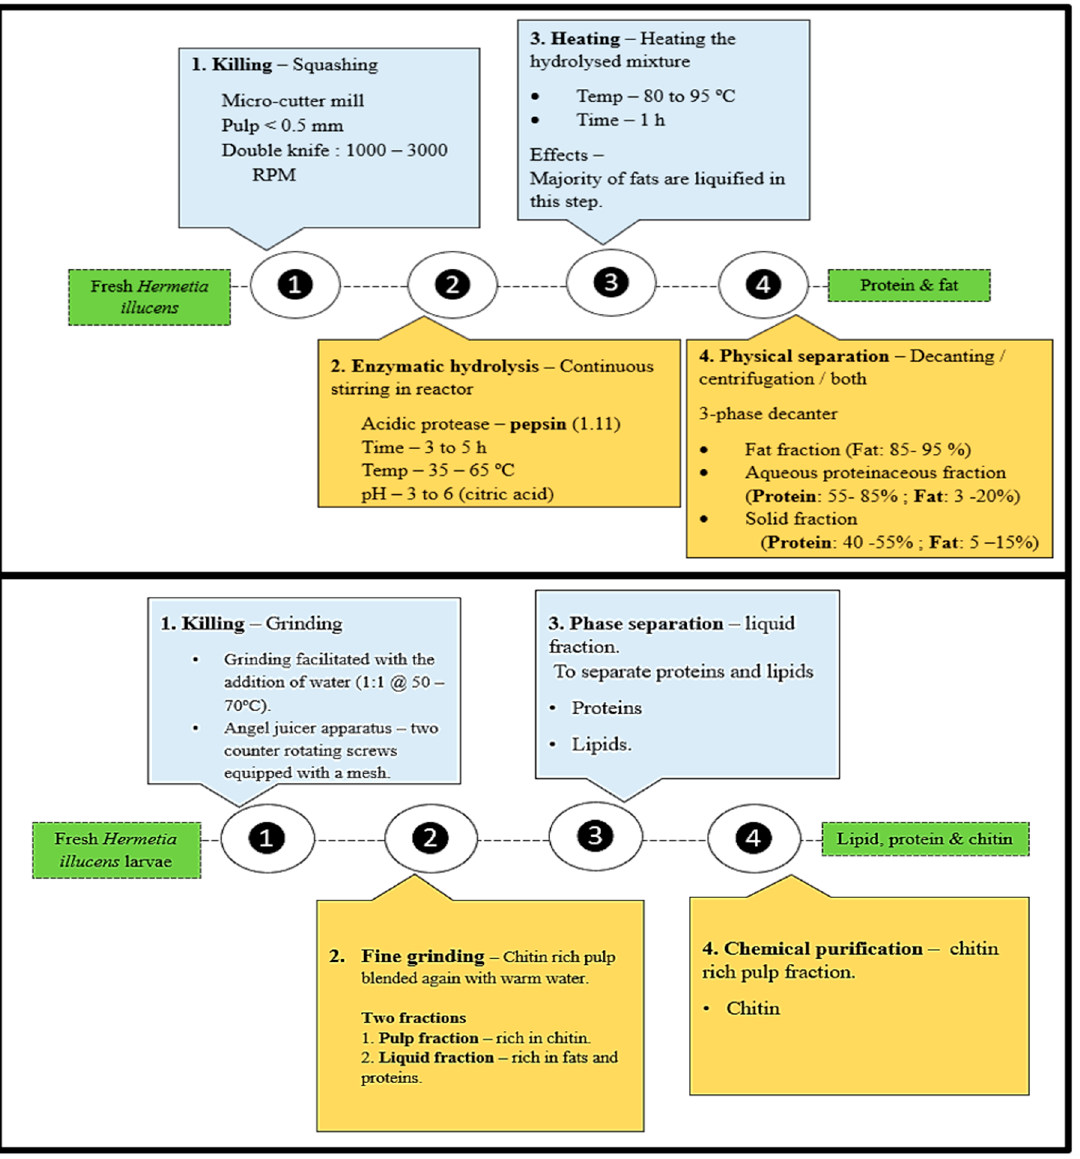
Figure 6. Breakdown of unitary operations in industrial patents.